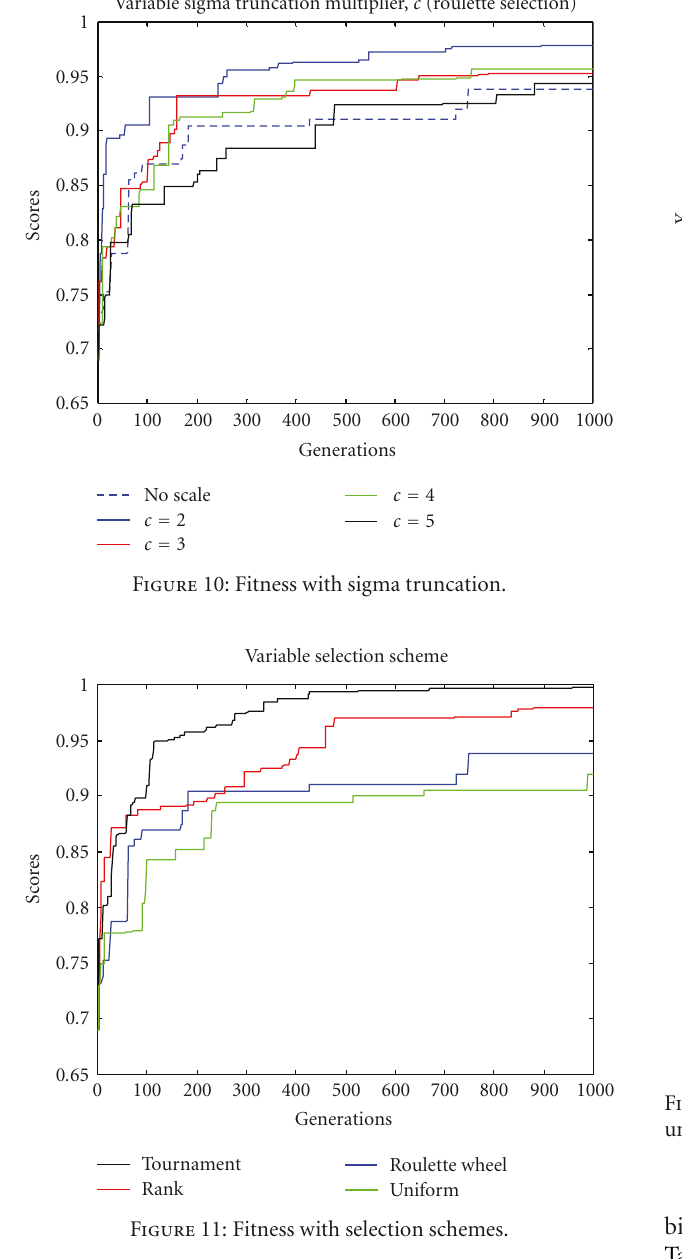
Figure 11: Fitness with selection schemes.